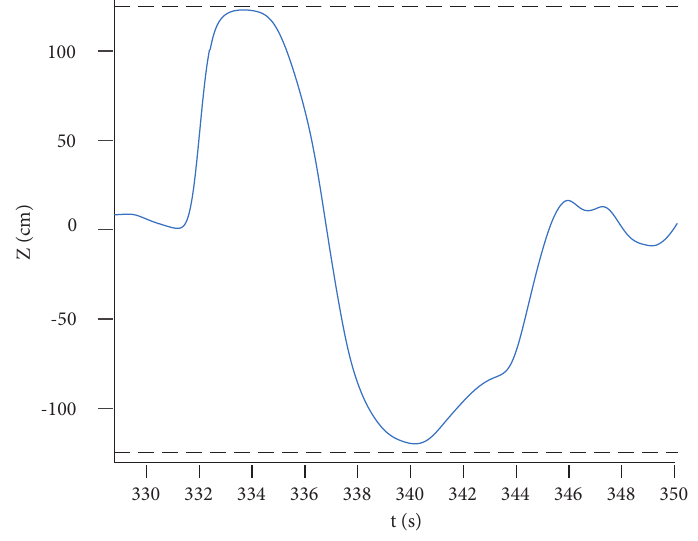
Figure 11. Zoom on the Z-axis output (Fig. 8) of the proposed washout fi